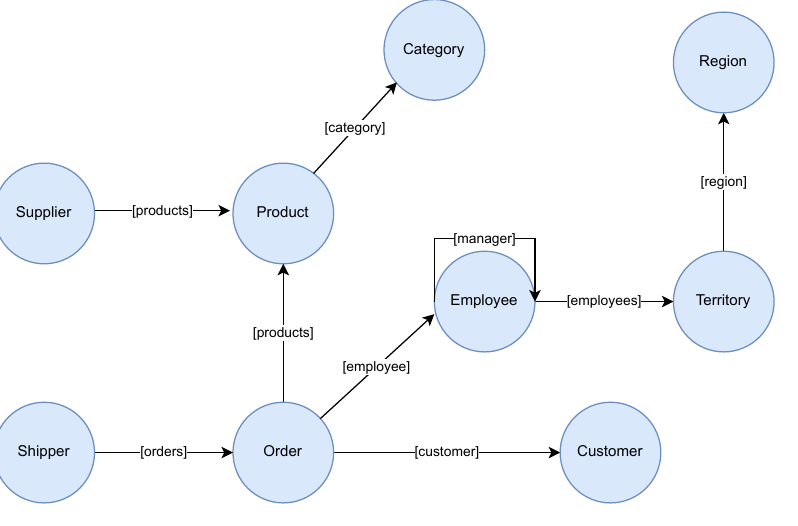
Figure 5. Northwind graph schema.